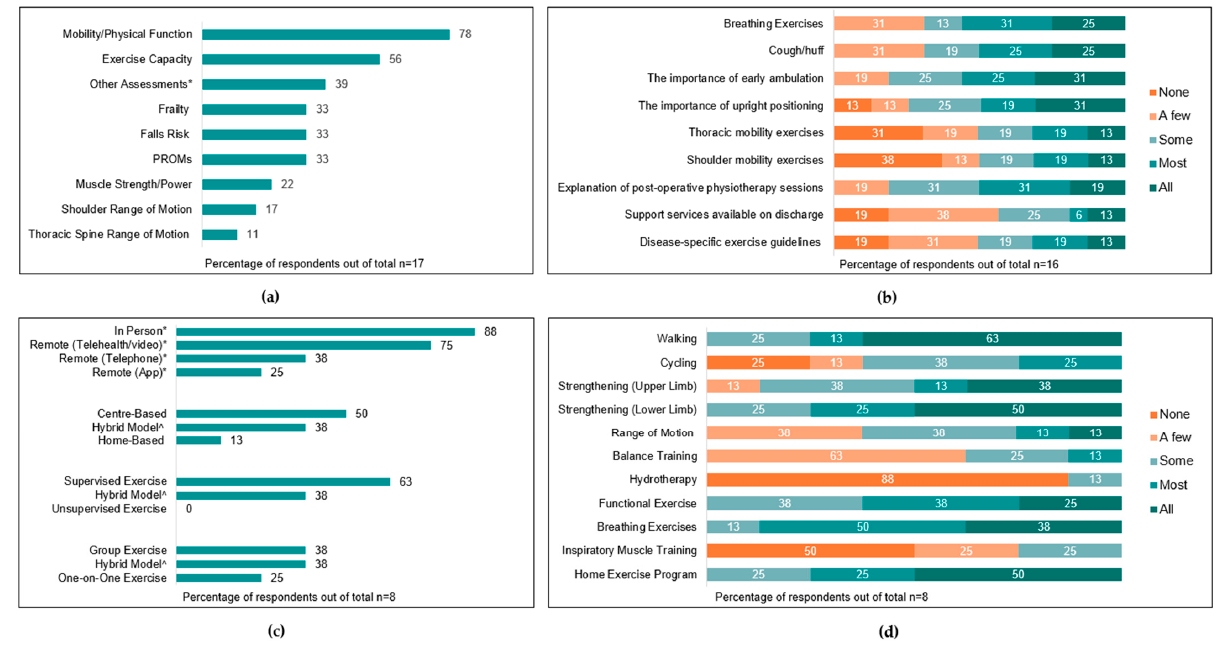
Figure 3. Pre-operative assessment and management of people awaiting surgical resection for lung cancer (%). ( a ) Types of assessments performed (PROMs = patient-reported outcome measures; * other answers provided: lung function testing, n = 7); ( b ) proportion of patients with lung cancer